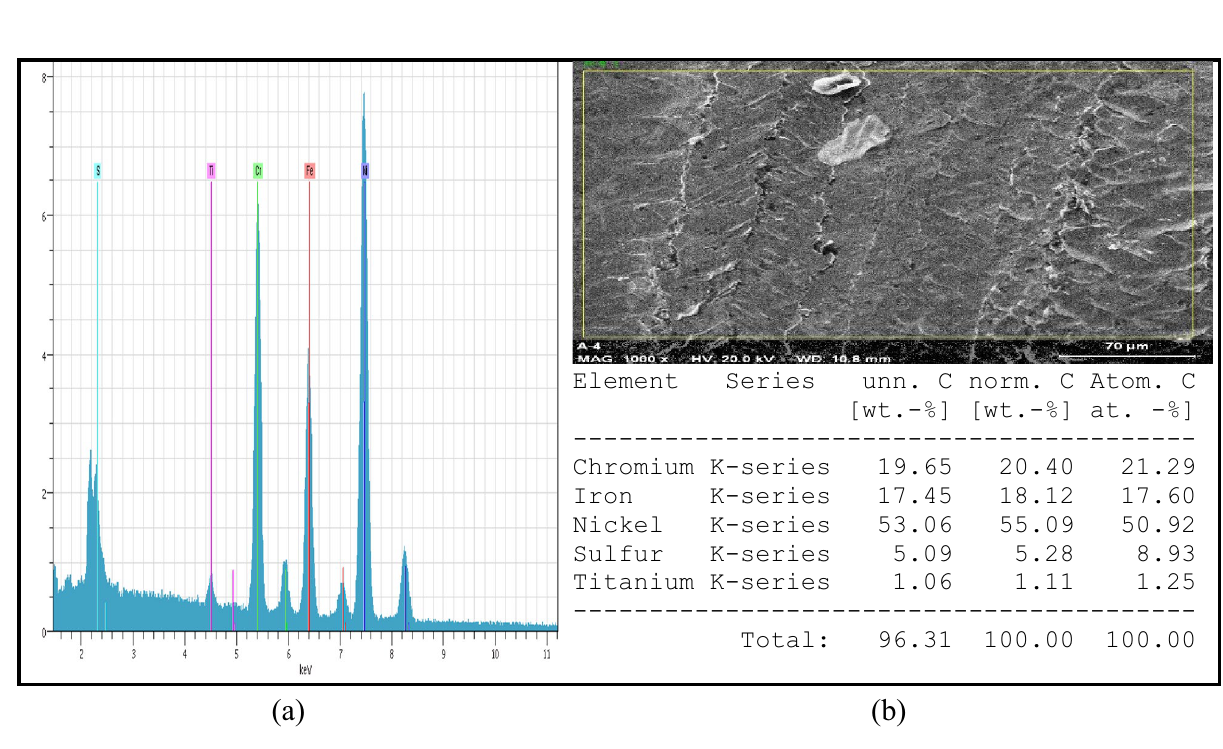
Figure 4. EDS analysis of Inconel